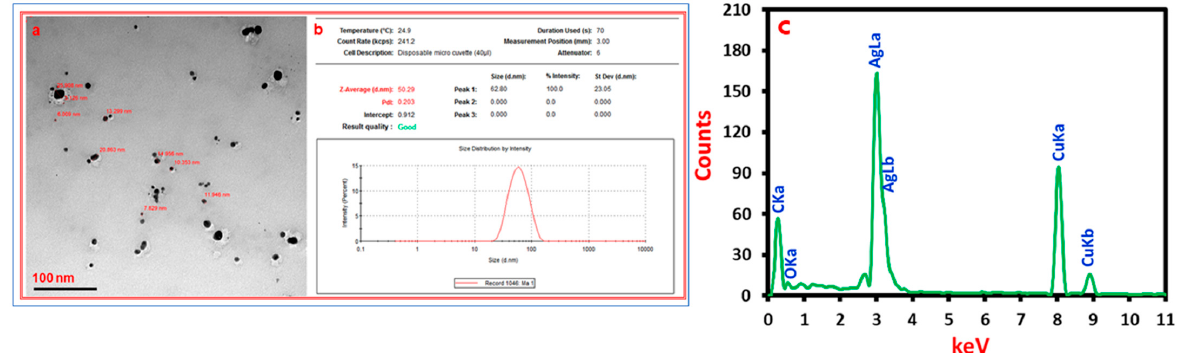
Figure 3. ( a ) TEM, ( b ) DLS measurements image of Ag NPs prepared from the extract of cranberries